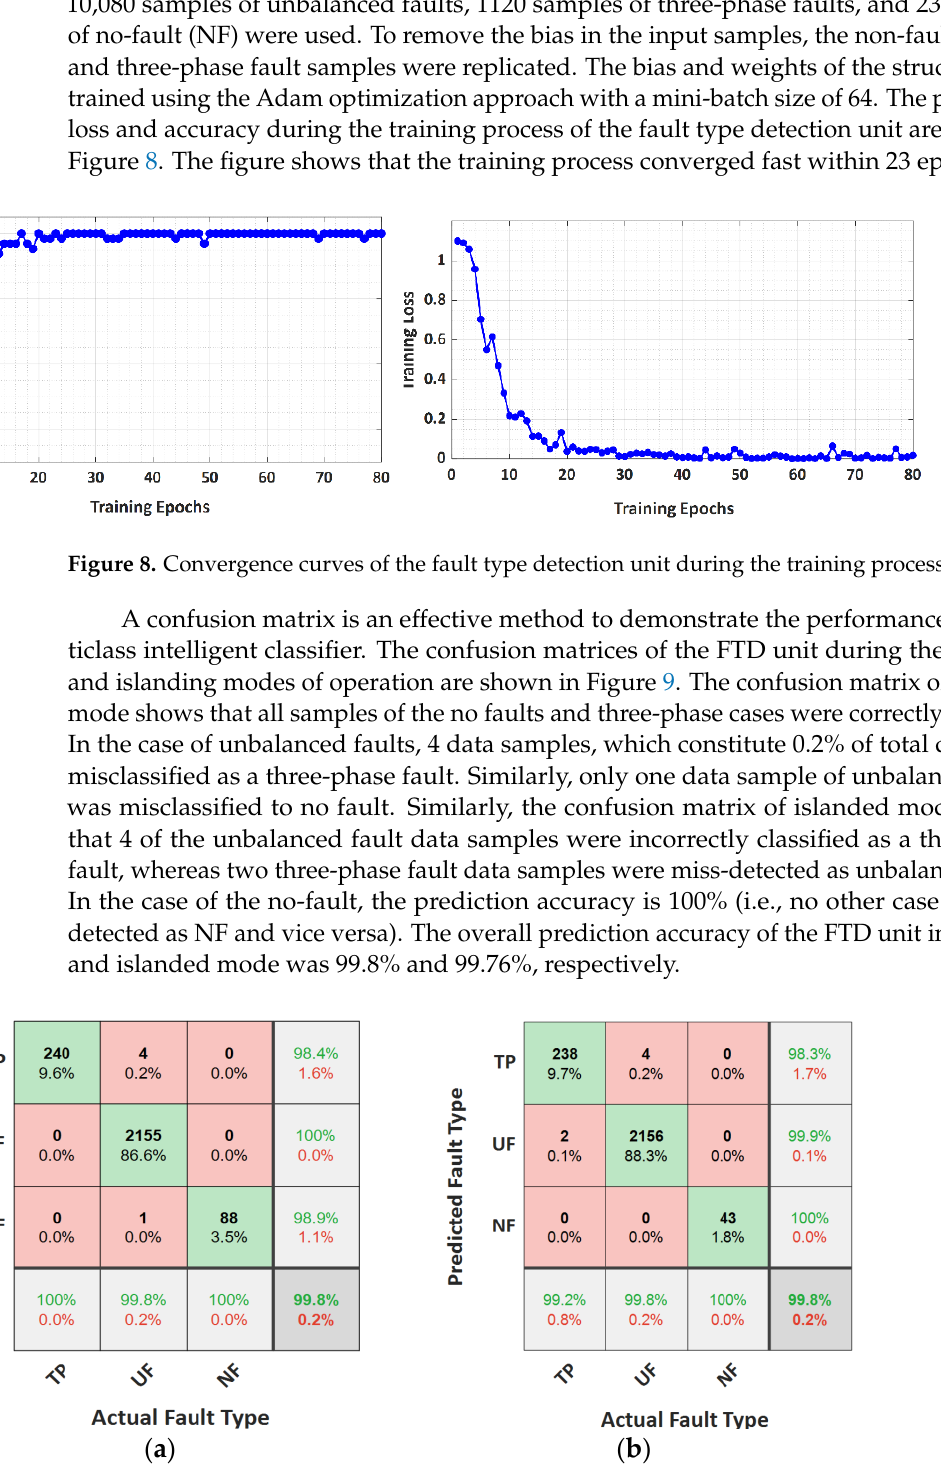
Figure 9. Confusion matrices of the testing dataset for FTD unit during: ( a ) grid-tied mode and ( b ) islanded mode.